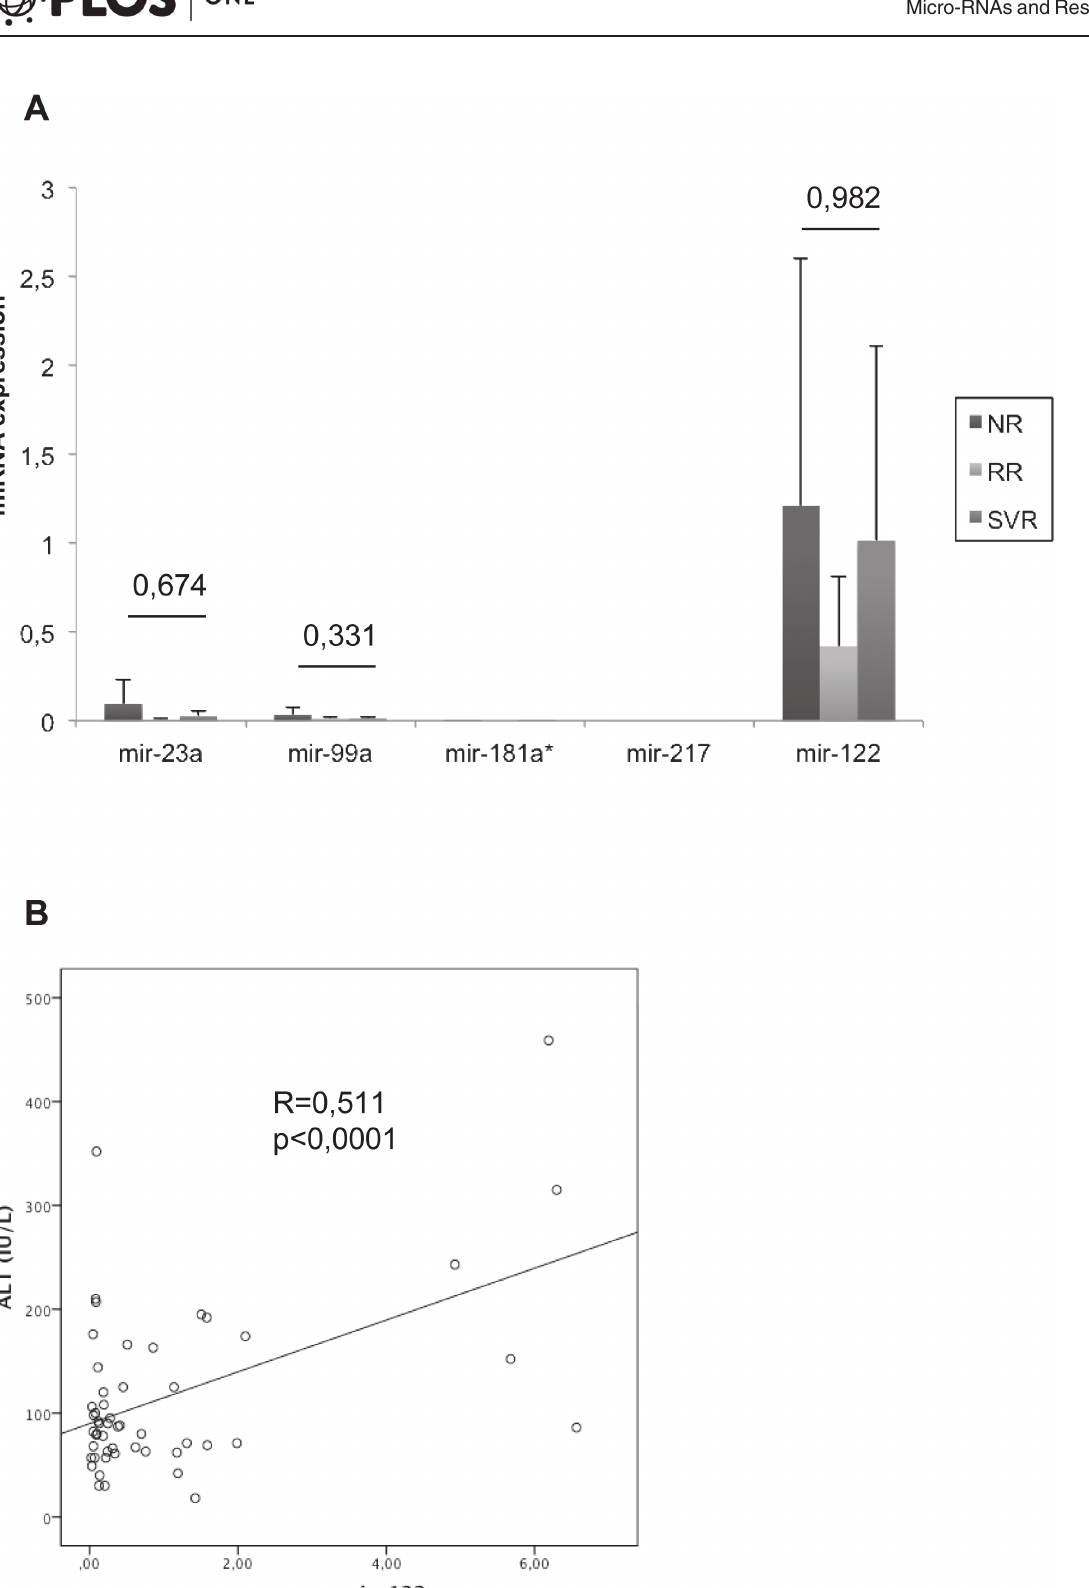
PLOS ONE | DOI:10.1371/journal.pone.0121395 April 6,